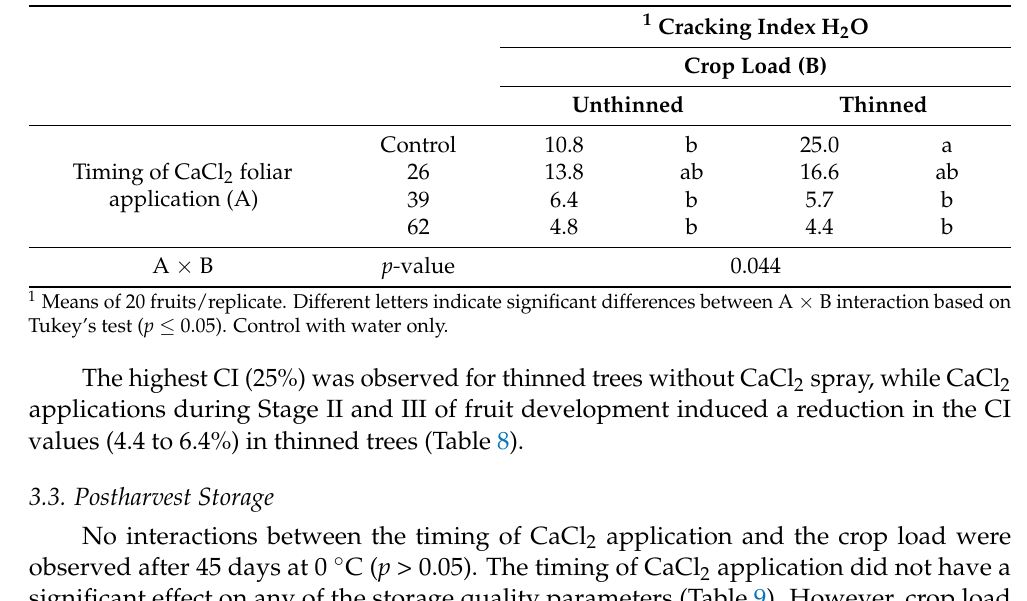
Table 9. Effect of the timing of foliar CaCl 2 applications (i.e., Control, and 26, 39, or 62 days after full bloom, DAFB) and crop load (natural crop load without fruit thinning vs. 50% of fruit removed